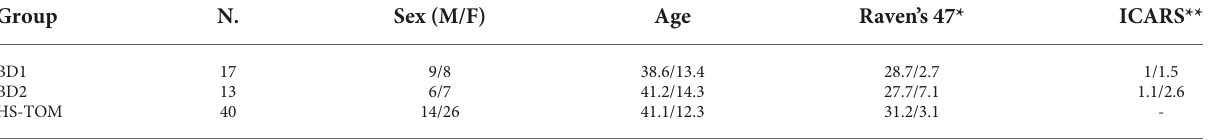
TABLE 1 Demographic data and clinical scores of the studied groups. Group N. Sex (M/F) Age Raven’s 47*